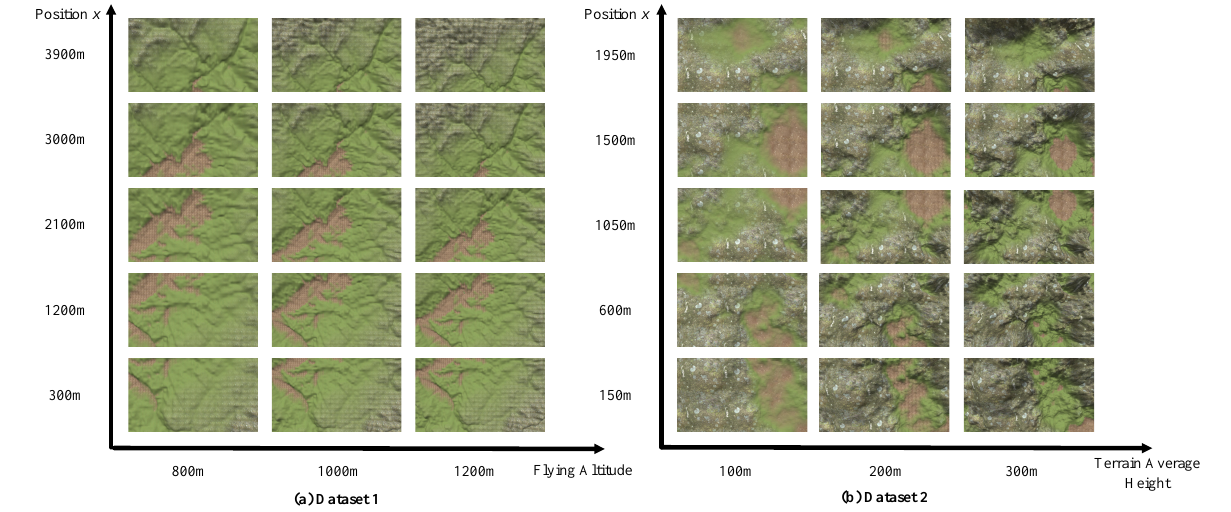
Figure 10. Example images of the datasets captured at different flight heights ( a ) and different terrain average height differences ( b ). Each of the two datasets contains three synthetic RGB image sequences together with the corresponding depth image sequences with a resolution of 960 × 540 and a frame rate of 30 per